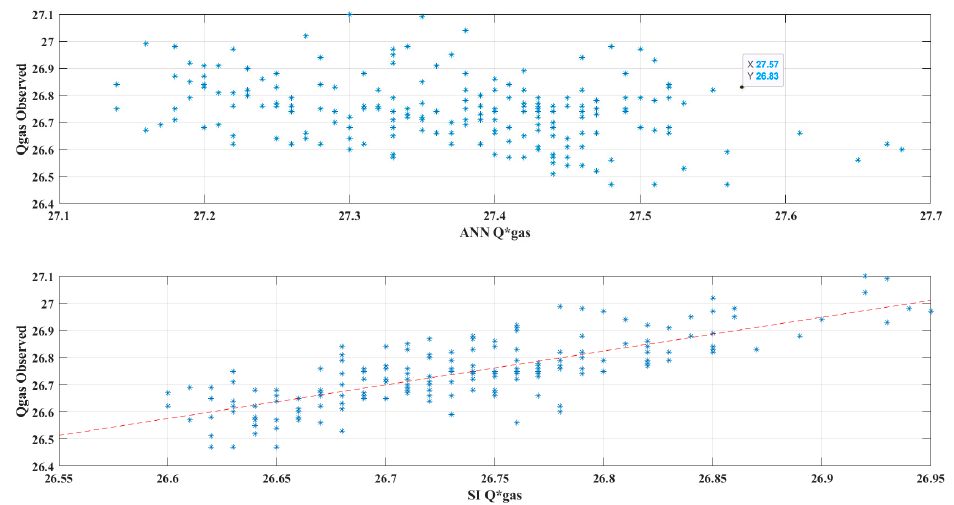
Figure 12. Comparison of the involved algorithms esteems (Q* gas ) and observed (Q gas ) variable for test 1.